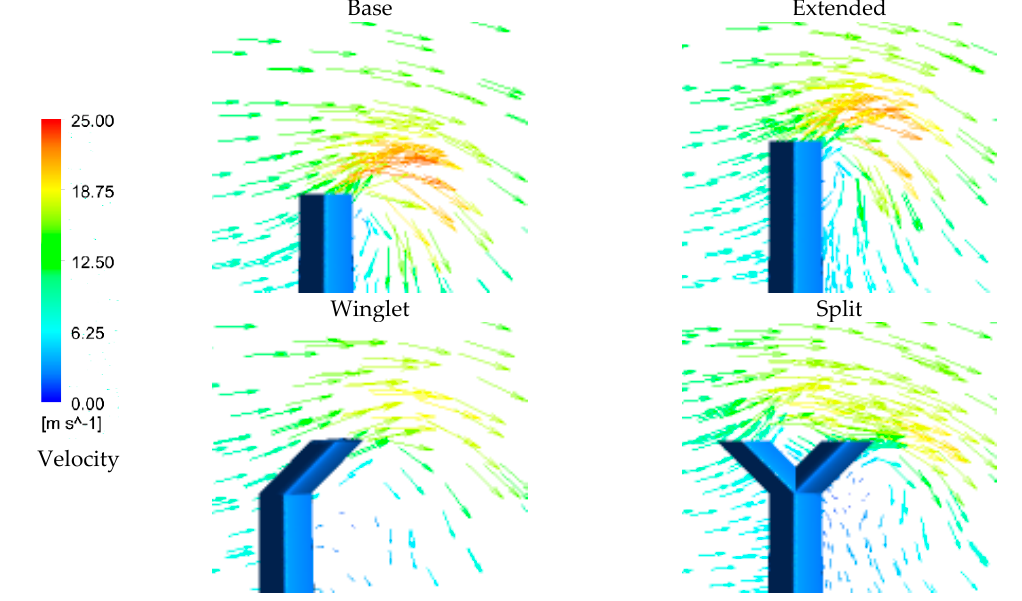
Figure 7. Tangential wind velocity at a plane just behind the trailing edge of the tip of the rotor blade and V = 11 m/s.